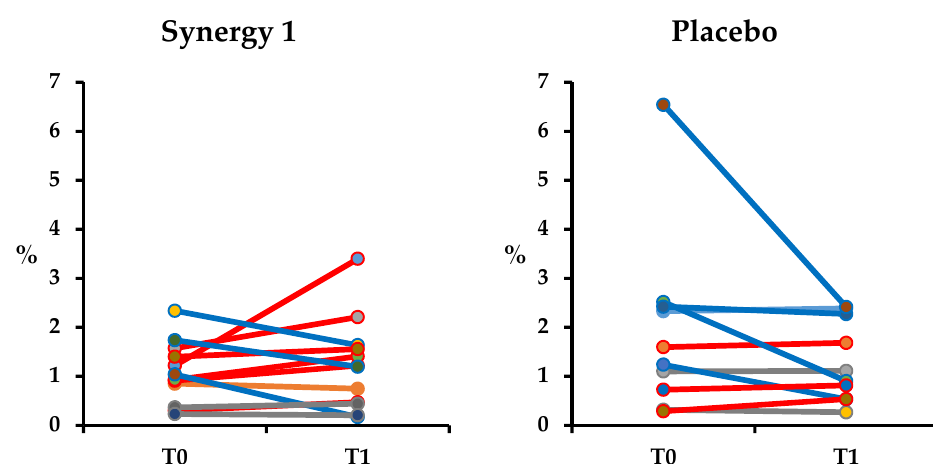
Figure 3. Urinary excretion of lactulose (L) in individuals from Synergy 1 and placebo group, before (T0) and after the intervention (T1), expressed as a percent (%) of total ingested L.